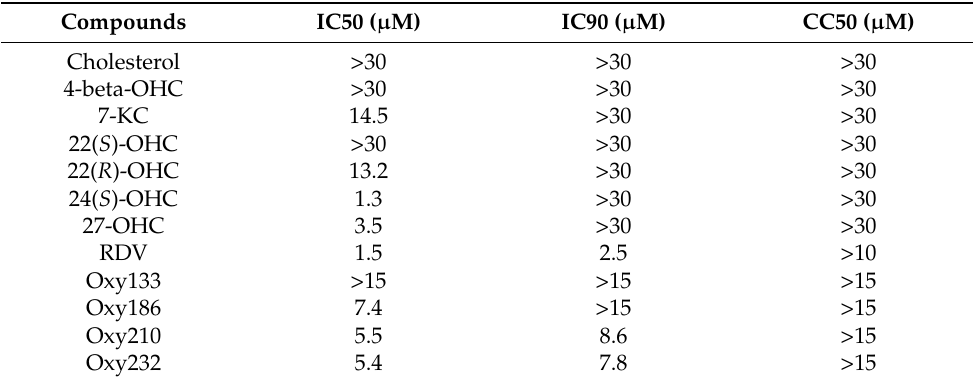
Table 1. The antiviral activities and cytotoxicities for all compounds. Compounds IC50 ( µ M) IC90 ( µ M) CC50 ( µ M) Cholesterol >30